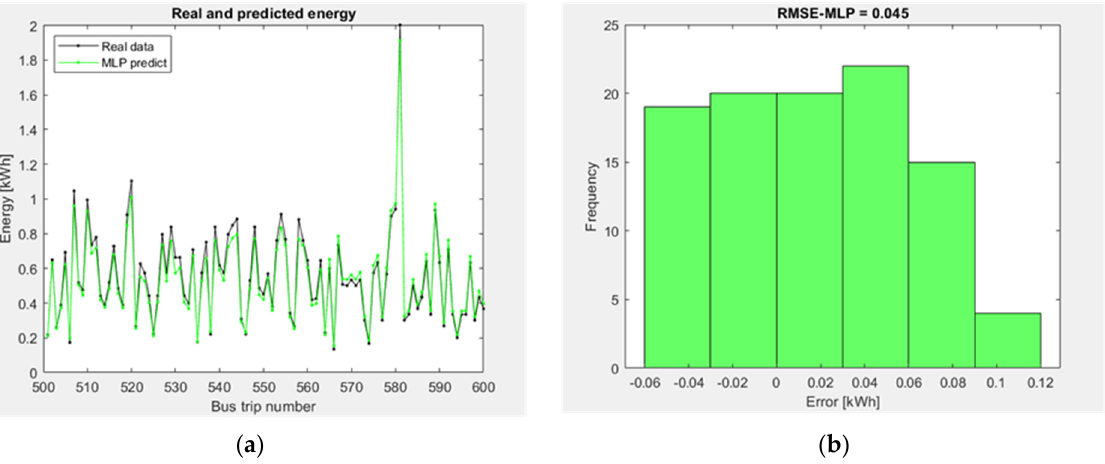
Figure 11. ( a ) Real and predicted energy consumption for test data from 501 to 600; ( b ) histogram for RMSE errors for LSTM networks for 100 test data.